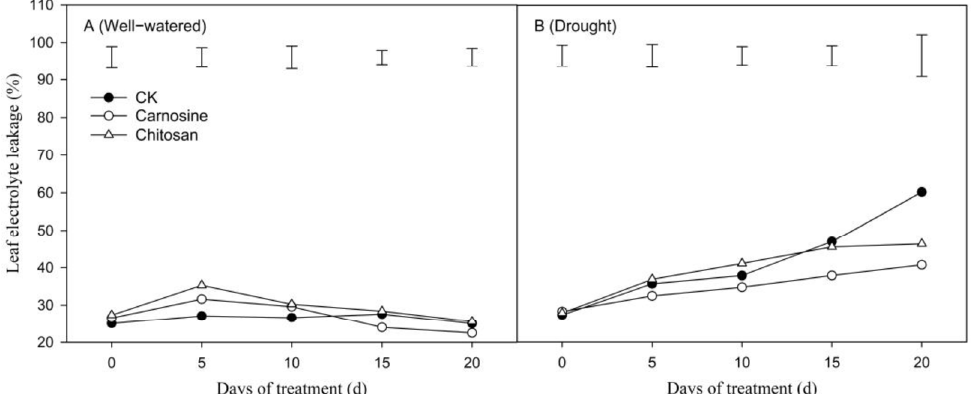
Figure 6. Effects of different concentrations of carnosine and chitosan on leaf electrolyte leakage under drought stress in bermudagrass. ‘CK’ represents control plants sprayed with distilled water under both well-watered and drought stress. Vertical bars represent LSD values where a significant difference ( p < 0.05) was detected among different treatments at the same time point.